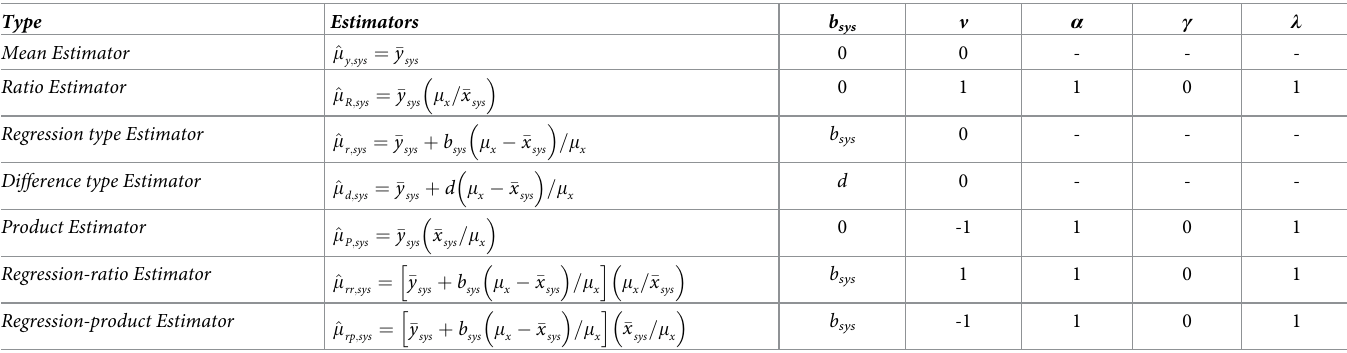
Table 1. Classical estimators as the family of the proposed